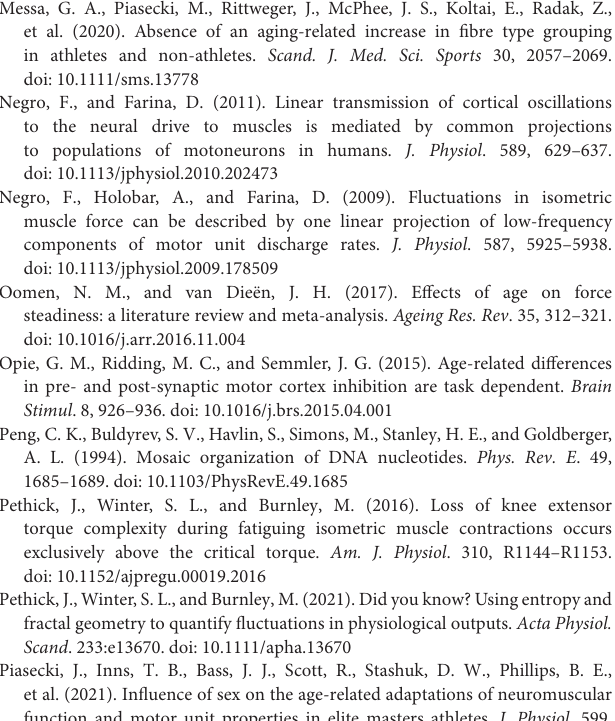
athletes: silhouettes of the trajectory of healthy human ageing? J. Physiol . 595, 2941–2948. doi: 10.1113/JP272443 Lazarus, N. R., and Harridge, S. D. R. (2018). The inherent ageing process and the facilitating role of exercise. Front. Physiol .